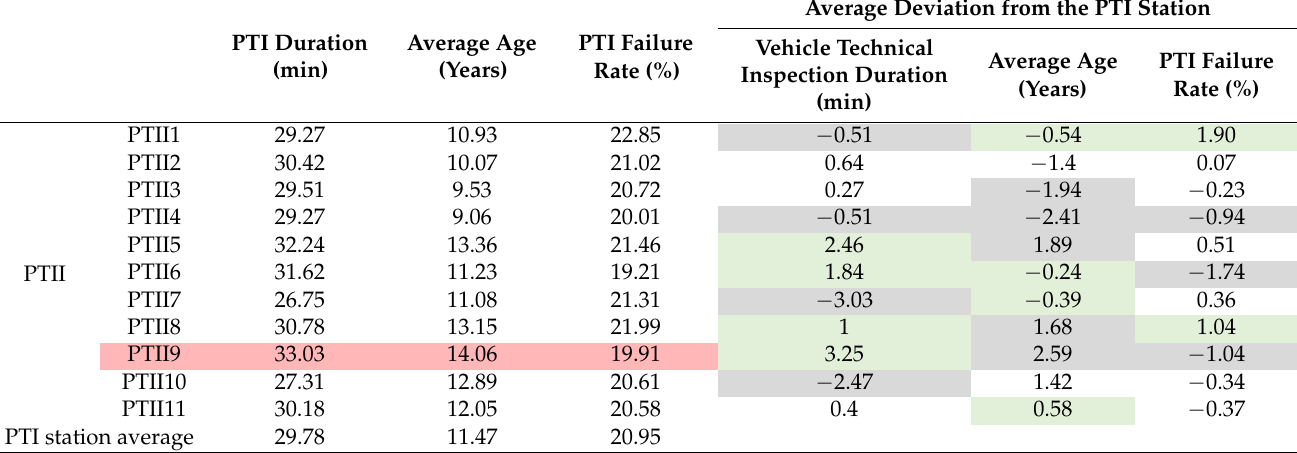
Table 4. Average values of defined parameter per